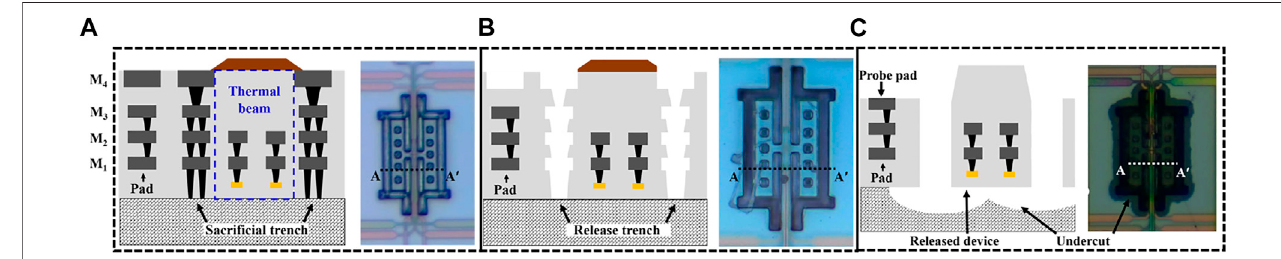
FIGURE6| Stepsforpost-fabricationreleaseoftheMEMS. (A) Opticalmicroscopeimage(OM)ofthediereceivedfromthefoundryanditscrosssectionalongAA ʹ . (B) OMaftermetalwetetchinganditsAA ʹ crosssectionshowingatrench. (C) OMafterdrySiO 2 etch(RIE)andisotropicdryetchofSiforrelease.Thesubstrateundercut can be seen in the